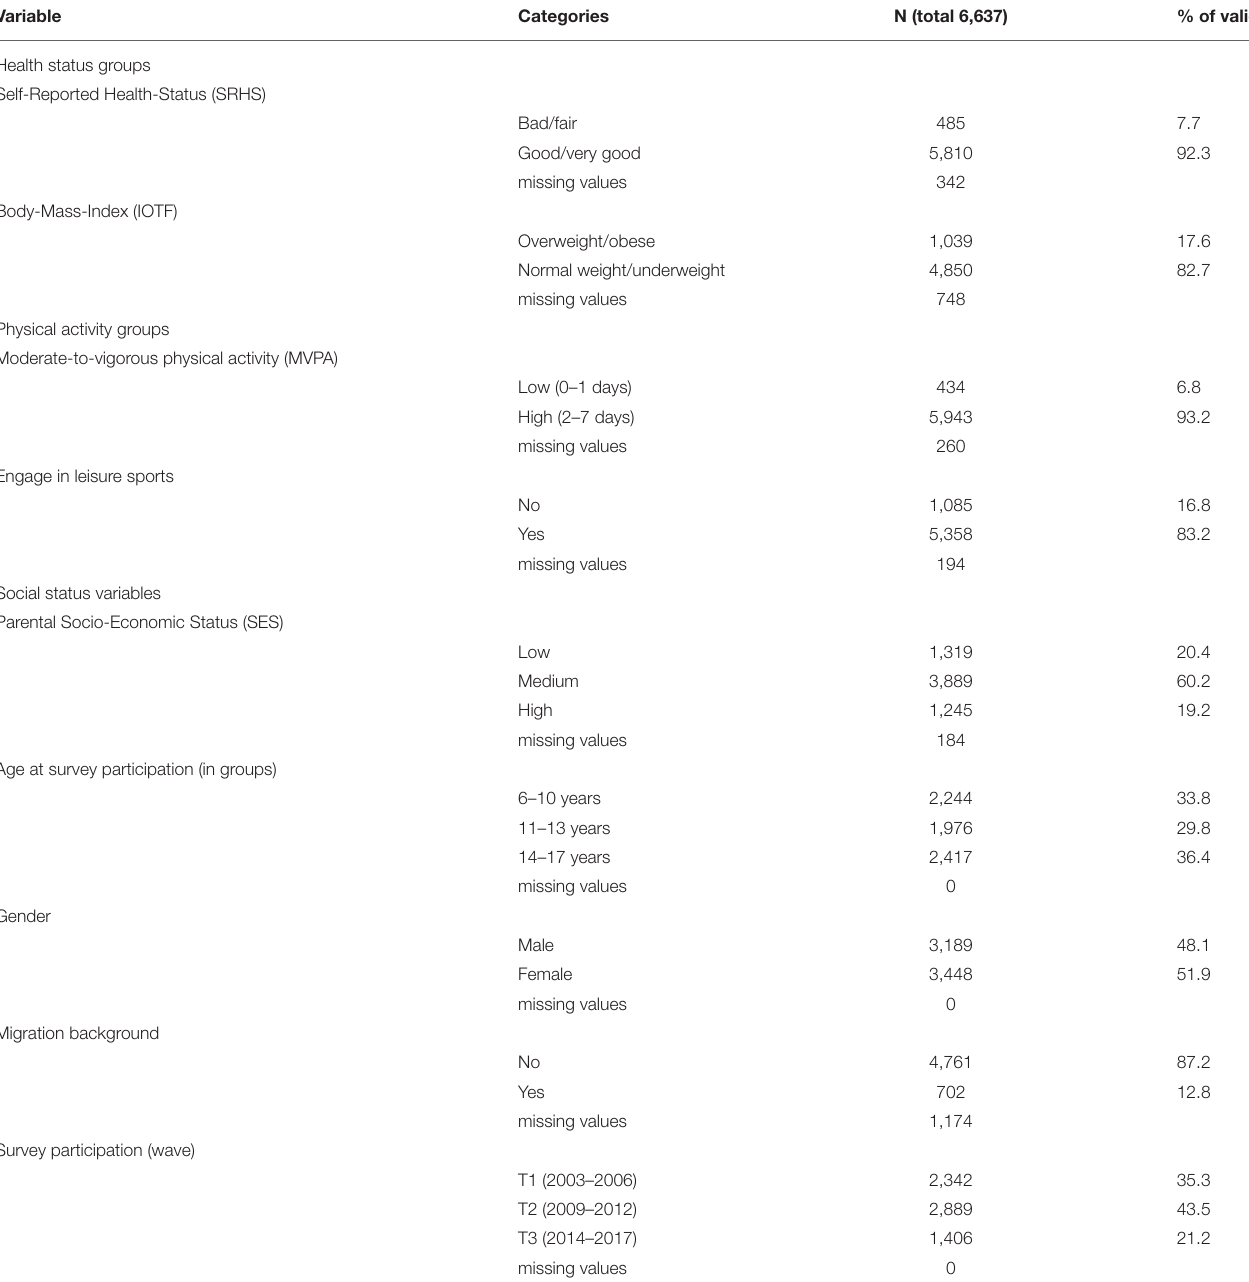
TABLE 1 | Distribution of variables from the working sample (pooled